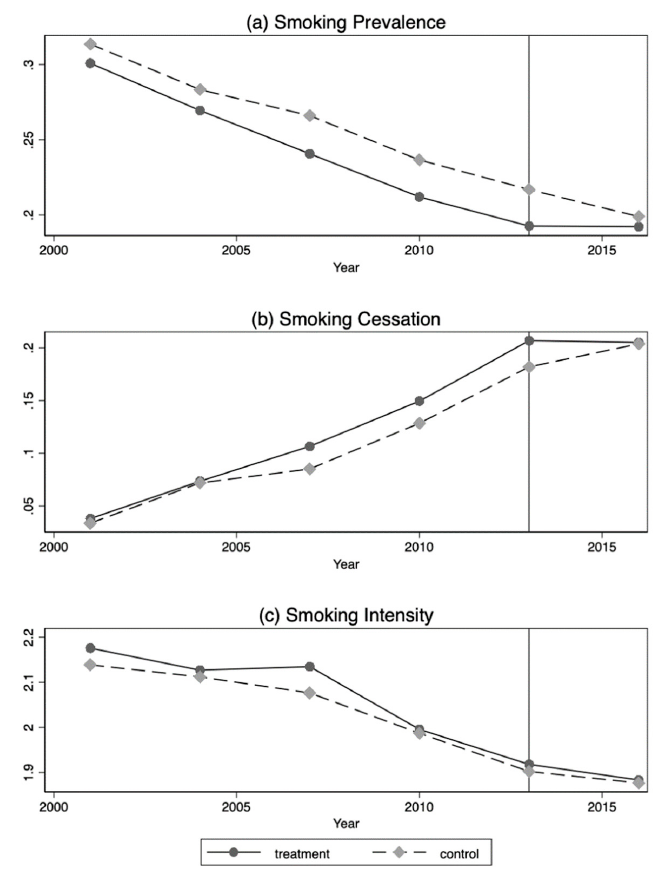
Figure 1. Smoking behaviors (Source: CSLC 2001–2016). Smoking prevalence (respondents who